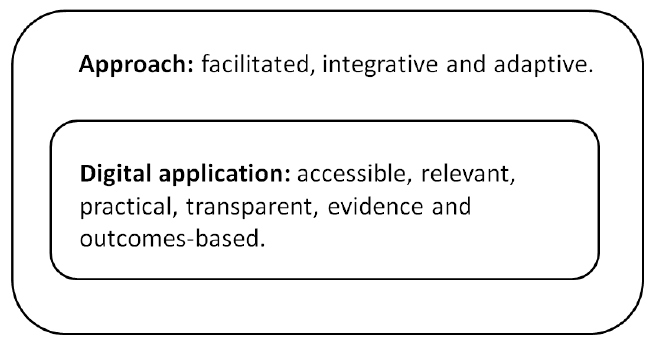
Figure 2. Researchers’ own draft principles, based on literature.